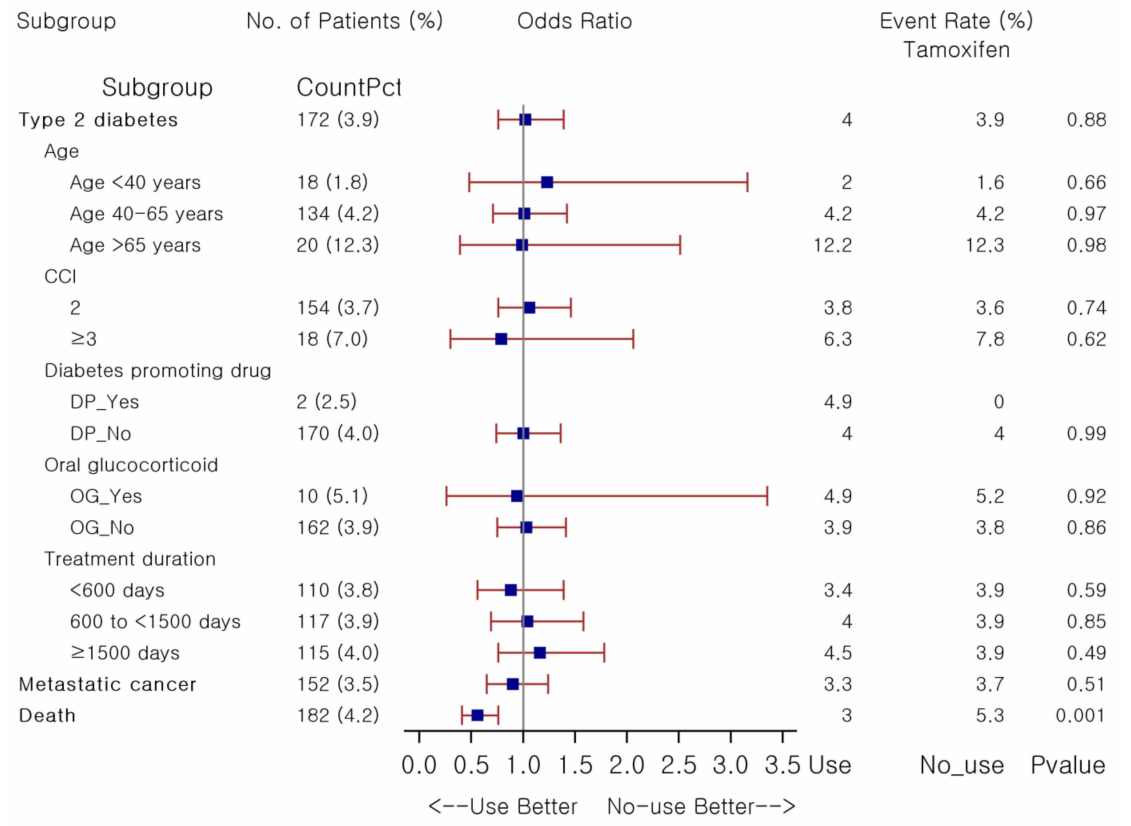
Figure 2. Forest plot for association between study outcomes and tamoxifen in female patients with breast cancer. Abbrevia- tions: CCI, Charlson Comorbidity Index; DP, diabetes promoting; OG, oral